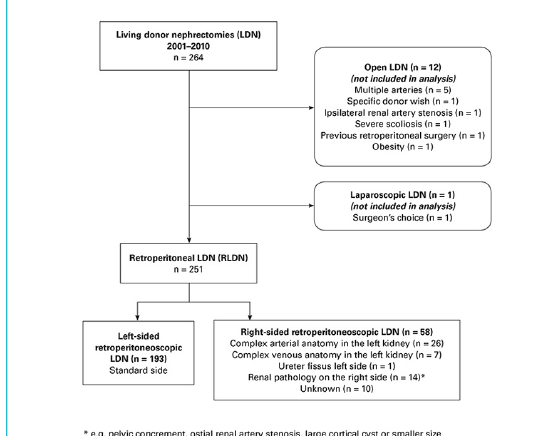
Figure 1: Selection of side of kidney for living donor nephrectomy.